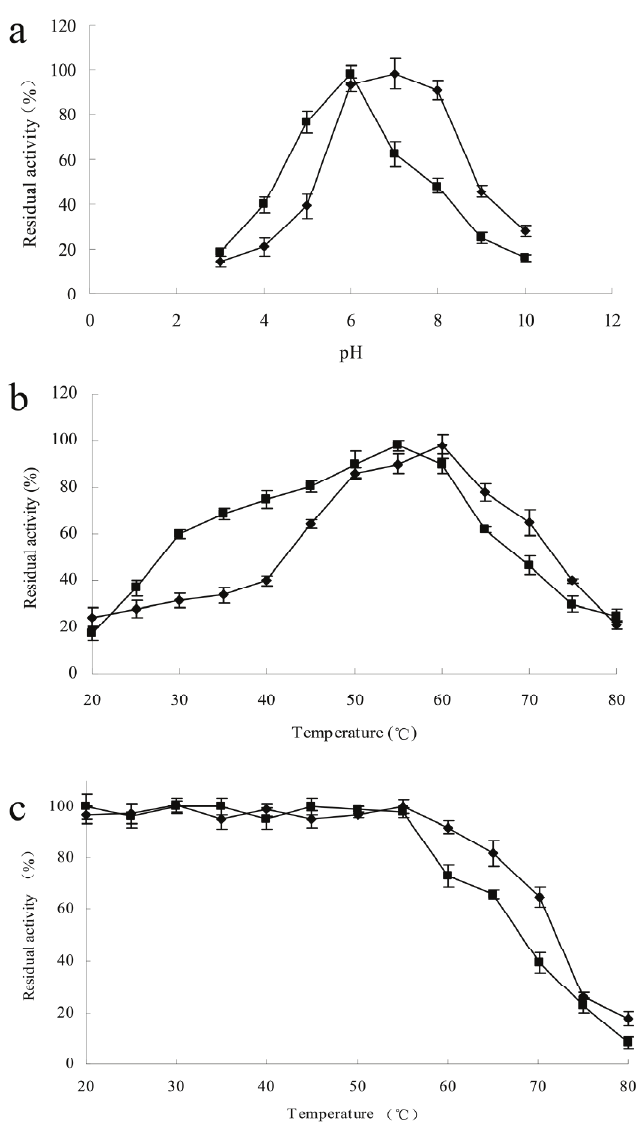
Figure 5. Characterization of ChiA ( (cid:441) ) and ChiC ((cid:5)) using colloidal chitin as substrate. Each point represents the average of three measurements. ( a ) pH activity profile; ( b ) Temperature activity profile; ( c ) Thermostability profile—The enzymes were incubated for 2 h at the indicated temperatures, after which residual activity was determined and the measurements from incubation at optimum conditions were used as the 100%